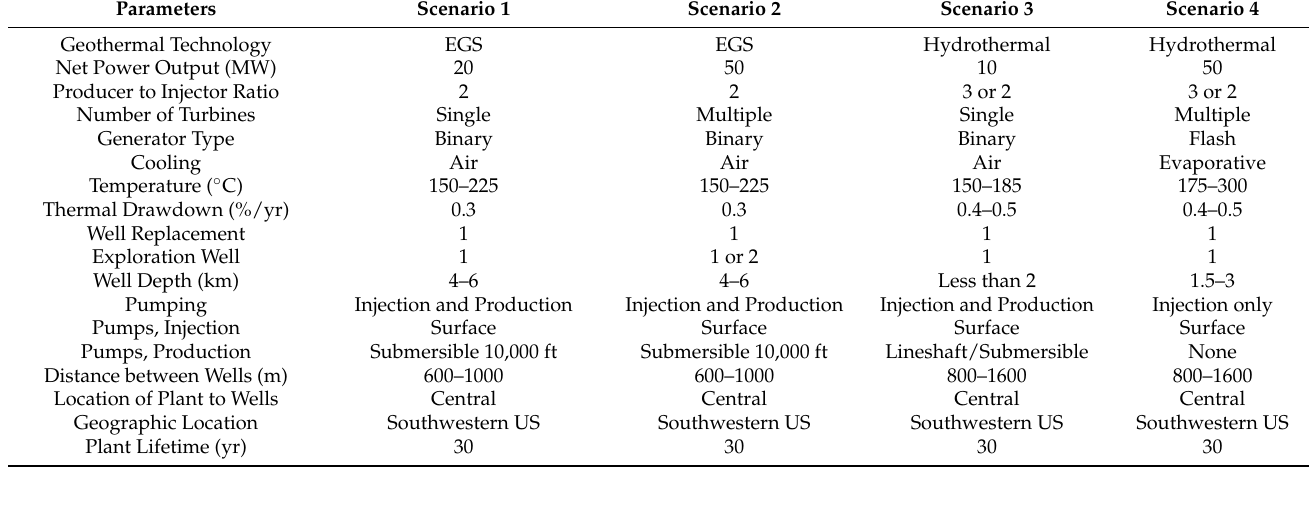
Table 1. Parameter values for the four investigated geothermal power plant scenarios [29].